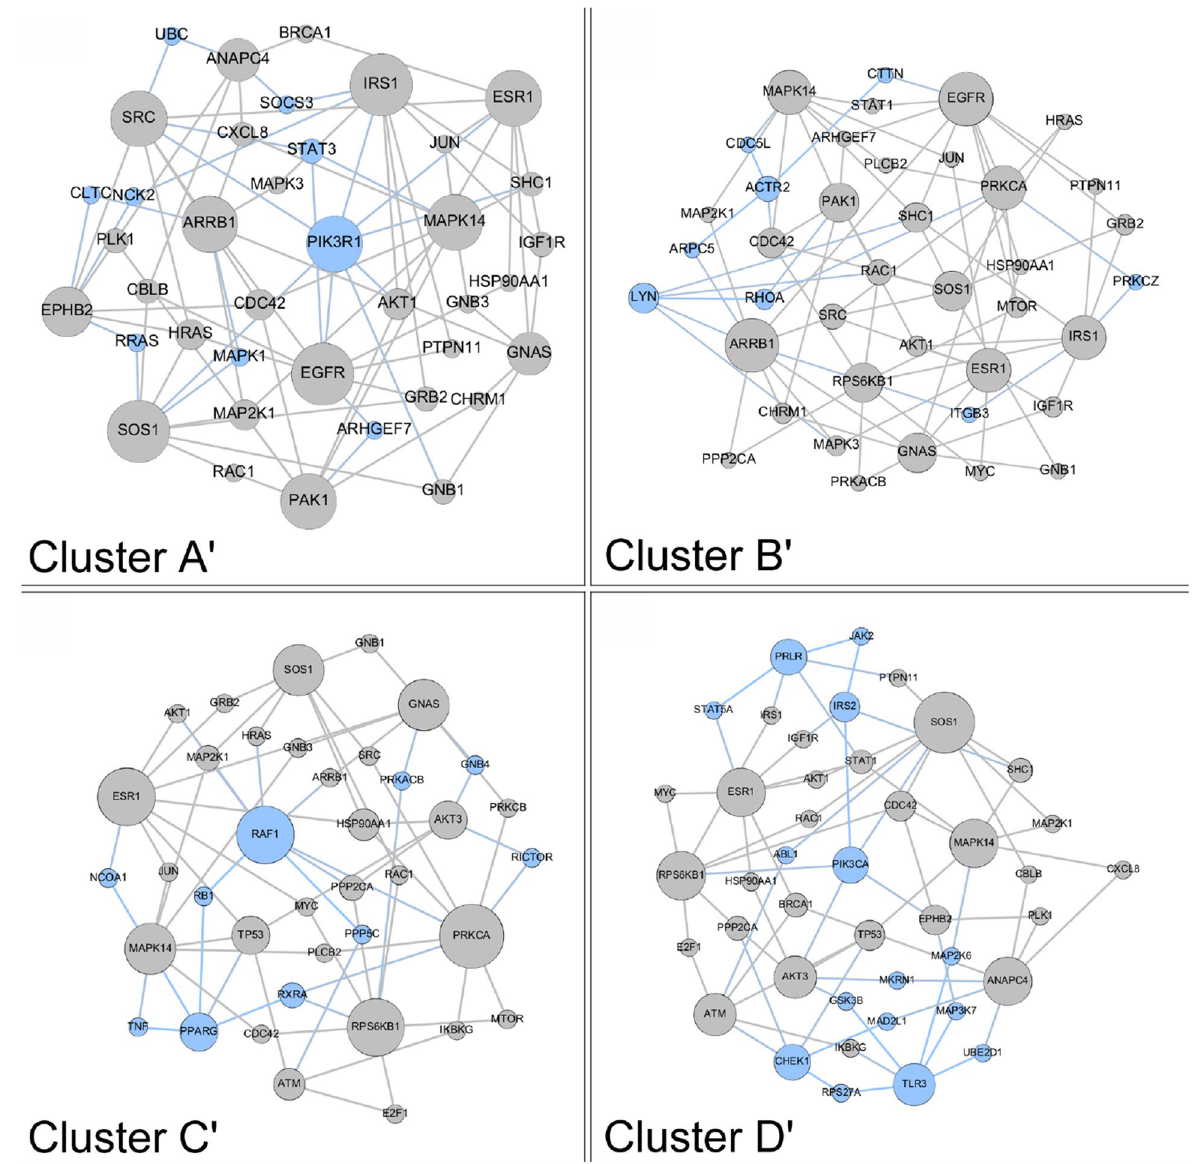
Figure 3. Layered network graphs for the INOVA replication cohort showing significant clusters A’, B’, C’, D’. Unique genes to each cluster are shown in light blue. Replication cohort A’ B’ C’ D’ Preterm birth Table 5. Separation scores for comparison of case dominated clusters from the preterm birth cohort and the replication cohort. The values in bold are significant.